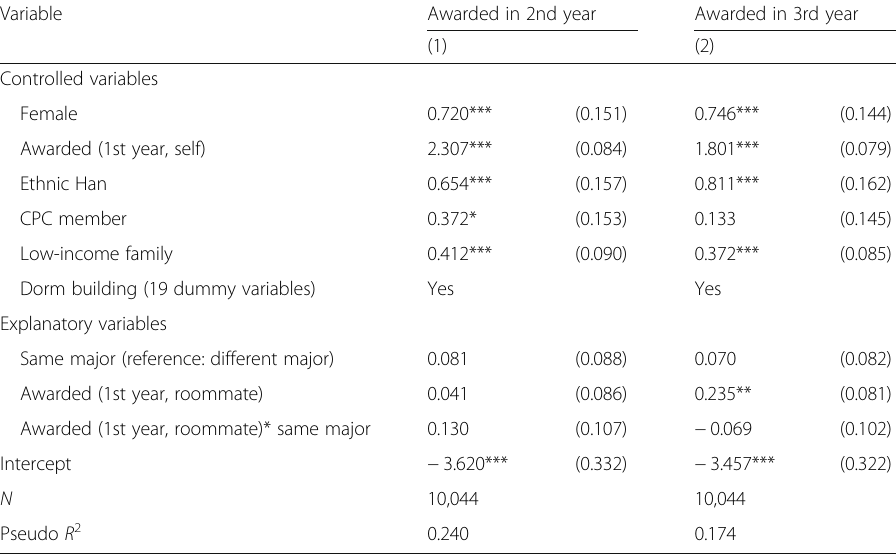
Table 3 Decomposition of peer social capital effect on academic achievement Variable